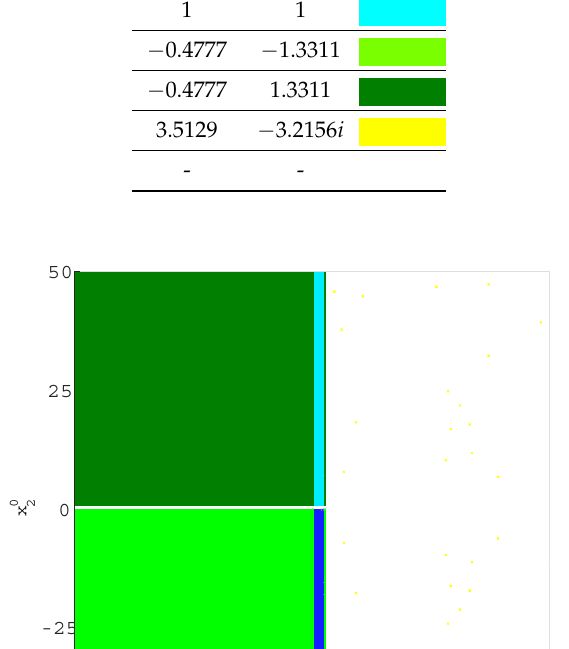
Table 2. Solutions for Kelley’s system.